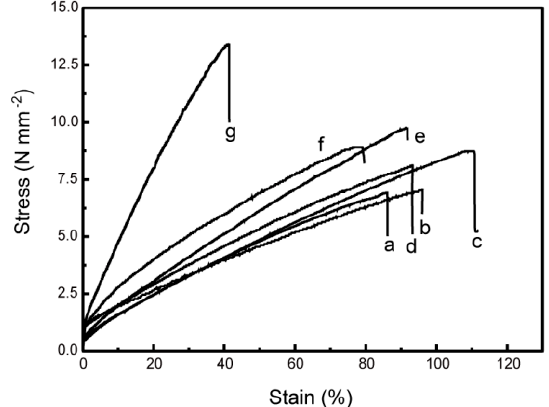
Figure 4. The stress–strain curves of the films with different content of MgO: ( a ) 0 wt %; ( b ) 1 wt %; ( c ) 3 wt %; ( d ) 5 wt %; ( e ) 7 wt %; ( f ) 10 wt %; and ( g ) 15 wt %. ( c ) 3 wt %; ( d ) 5 wt %; ( e ) 7 wt %; ( f ) 10 wt %; and ( g ) 15 wt %.